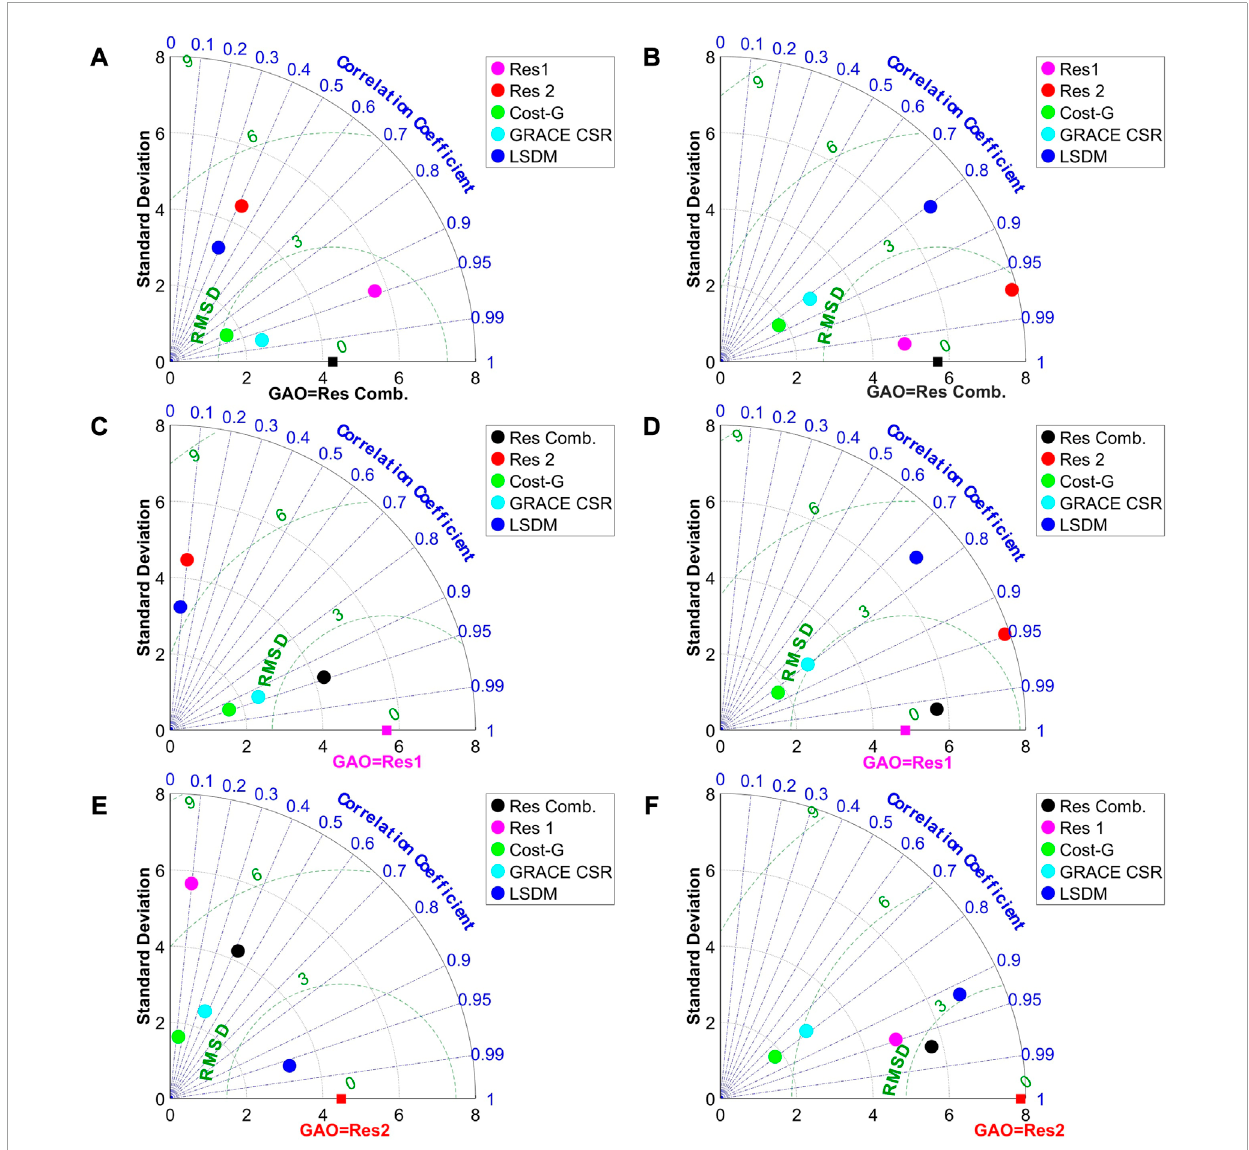
FIGURE 7 Taylor diagrams showing a comparison of χ 1 and χ 2 seasonal components of three different geodetic residuals as a reference vlaues: (A) χ 1 of Res Comb. (B) χ 2 of Res Comb., (C) χ 1 of Res1, (D) χ 2 of Res1, (E) χ 1 of Res2, (F) χ 2 of Res2, with gravimetric-based excitation determined from a single GRACE/GRACE-FO solution (CSR), combined GRACE/GRACE-FO solution (COST-G), and HAM LSDM hydrological